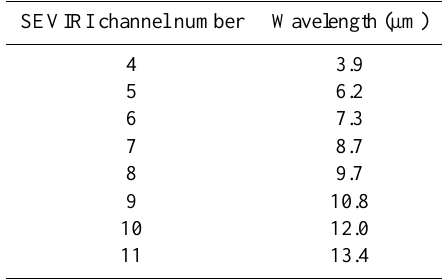
Table 1. SEVIRI infrared